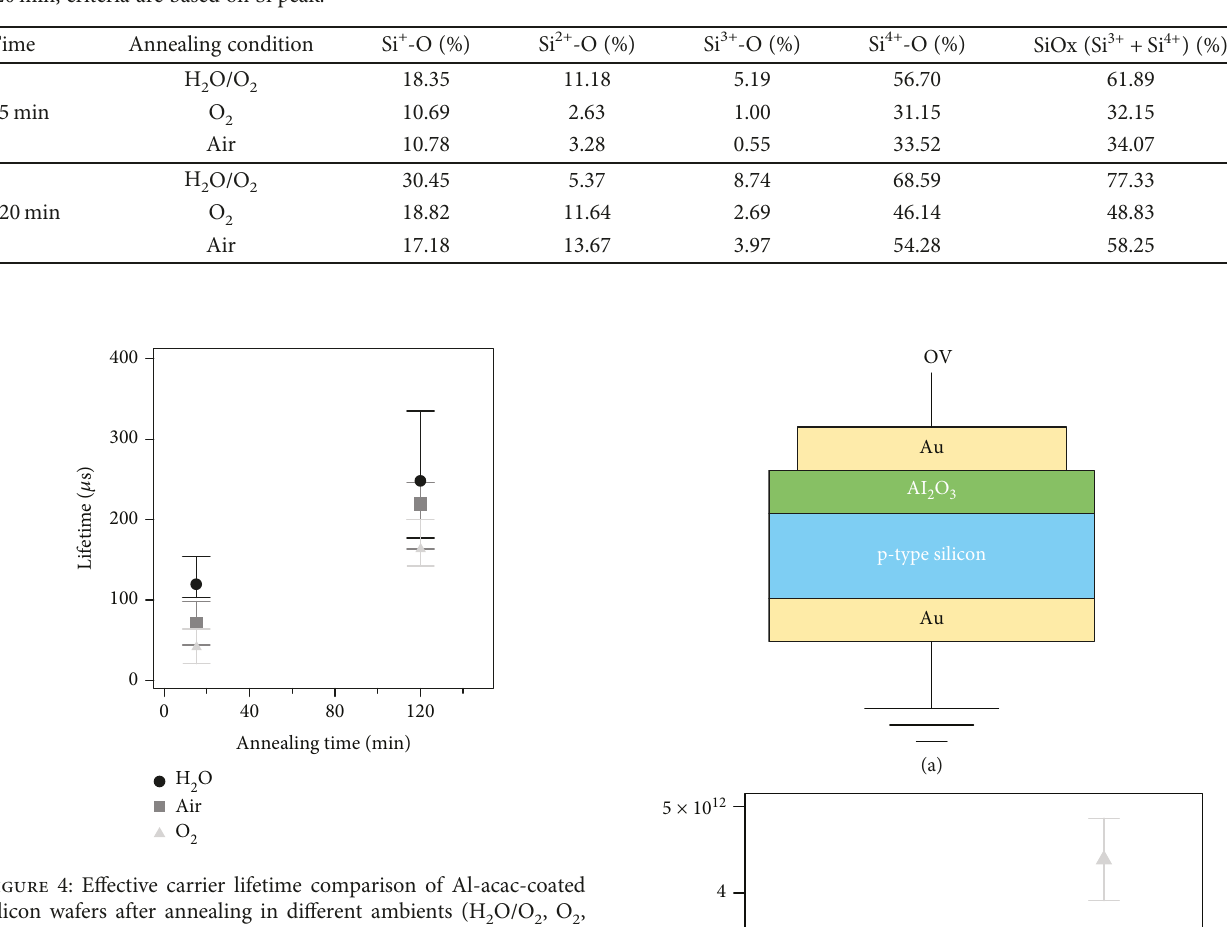
fi lm in various ambients for 15 or after annealing of AlO x x